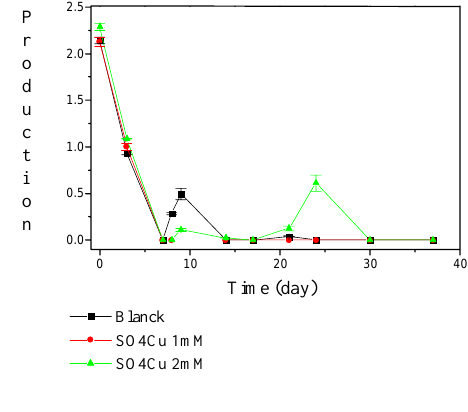
Figure 1. Cu SO effect on biomass Figure 2. CuSO 4 production [Biomass (g dry weigth/ml)]. accumulation [Production (mg/ g